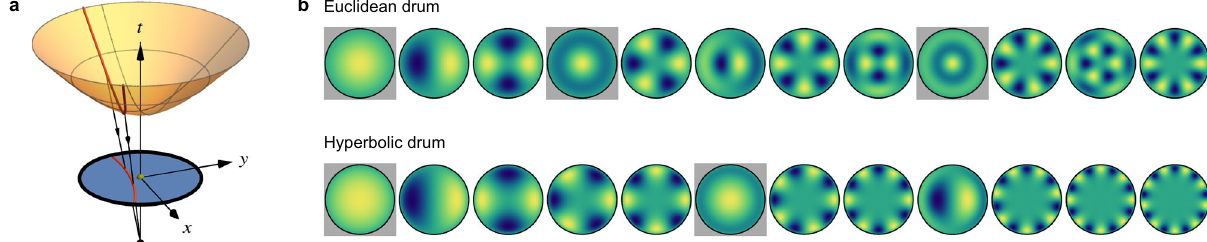
Fig. 1 | Continuum spectra. a The hyperboloid (orange) de fi ned by t 2 − x 2 − y 2 =+1 in (2+1)-dimensional ( x , y , t ) Minkowski space is mapped (black rays) by the ste- reographicprojectionthroughthepoint(0,0, − 1)(blackdot)totheunitdisk(blue) at t =0. The geodesics (red) are given by intersections of the hyperboloid with planes passing through the origin (0,0,0) (green dot), and are mapped by the projection to circular arcs perpendicular to the boundary of the Poincaré disk.